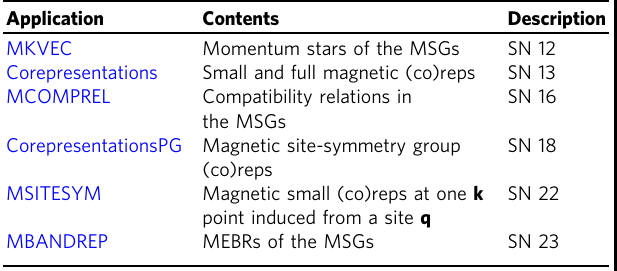
Table 1 Applications on the Bilbao Crystallographic Server implemented for